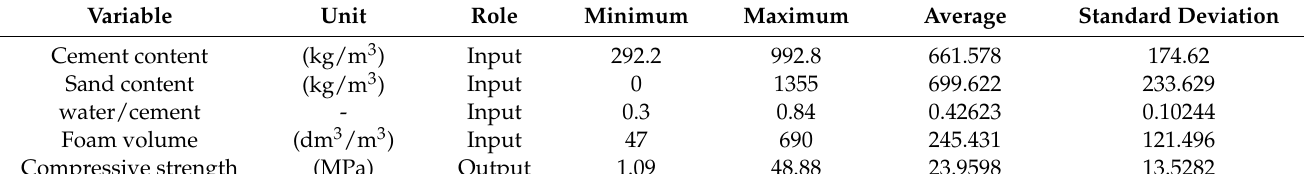
Table 1. Statistics of collected data.